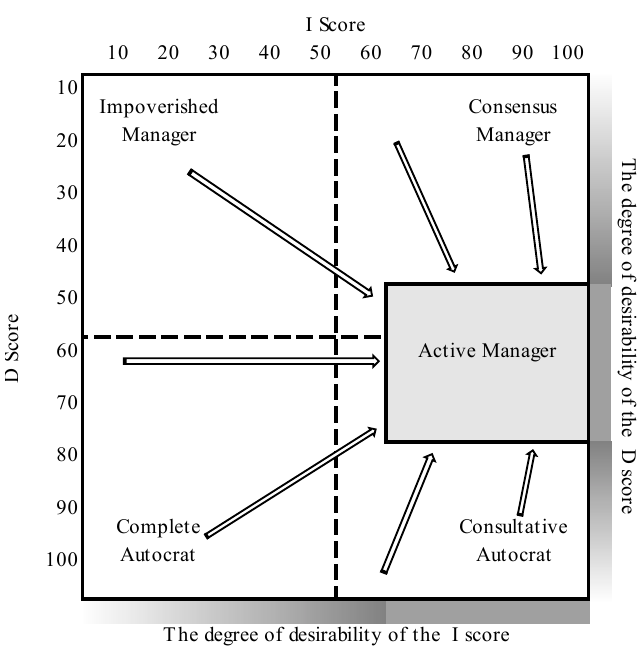
Figure 1. Leadership-teamwork flexibility space (Improved from [21]).